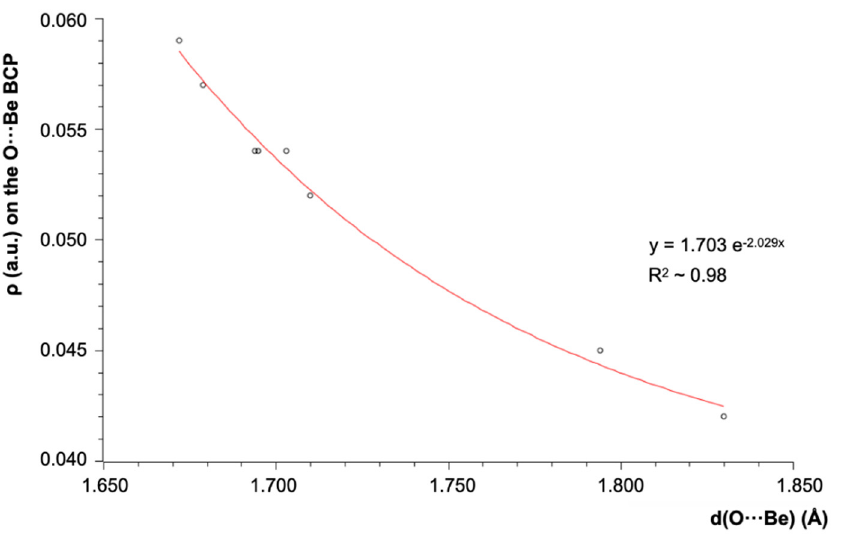
Figure 7. Exponential correlation between the Be-O distance and the density values at the bond critical point for the whole -OH series.